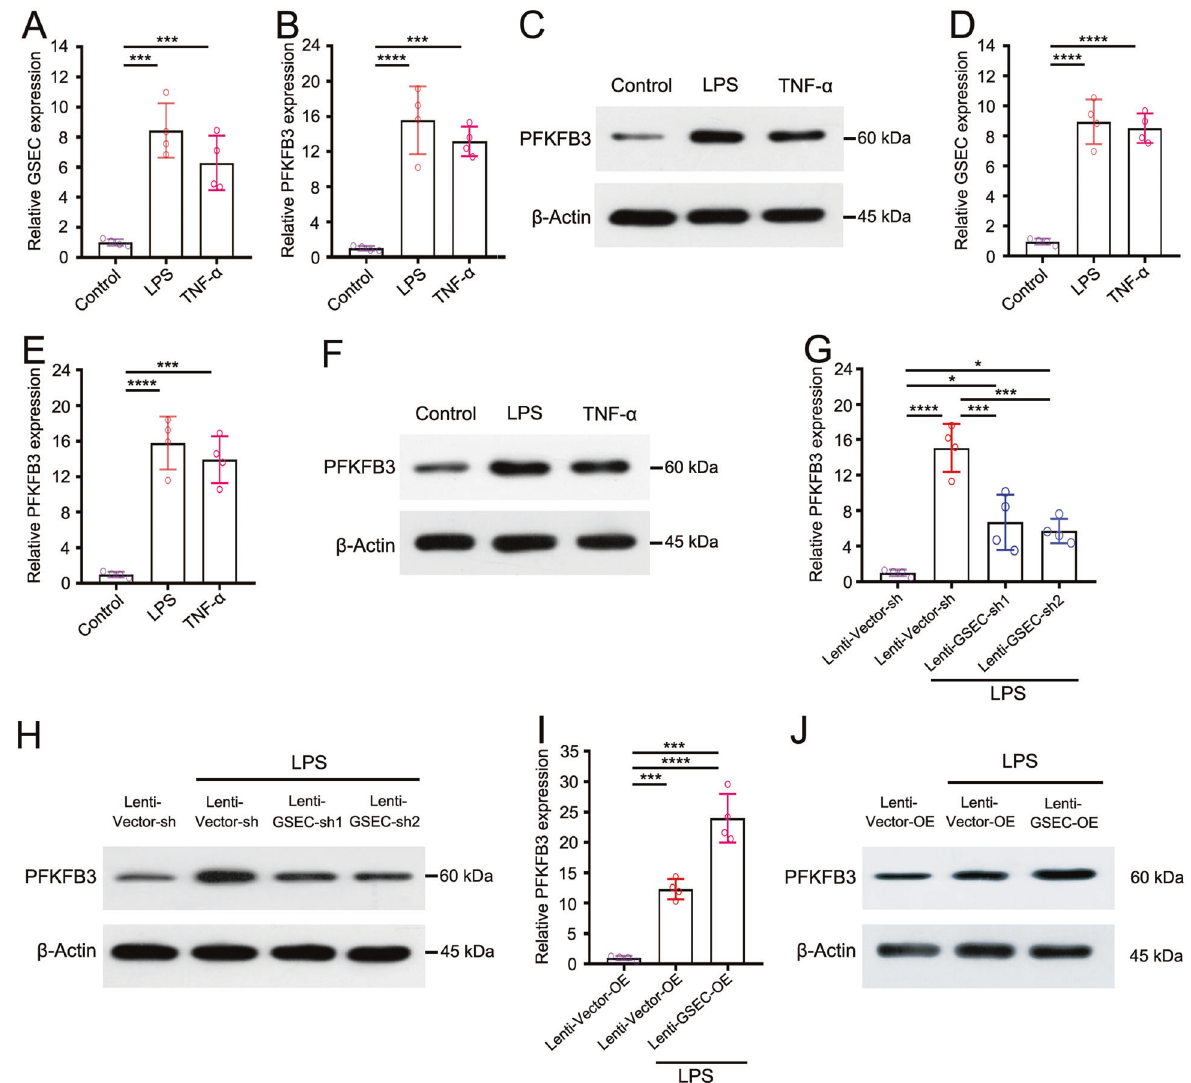
Fig. 4 GSEC is essential for PFKFB3 expression in in fl ammatory neutrophils. A The expression level of GSEC in primary human neutrophils. B The expression level of PFKFB3 in primary human neutrophils. C Western blot analysis of PFKFB3 in primary human neutrophils. D The expression level of the GSEC in dHL-60 cells. E The expression level of PFKFB3 in dHL-60 cells. F Western blot analysis of PFKFB3 in dHL-60 cells. G The level of PFKFB3 expression in GSEC-knockdown dHL-60 cells. H Western blot analysis for PFKFB3 in GSEC-knockdown dHL-60 cells. I The level of PFKFB3 expression in GSEC-overexpressing dHL-60 cells. J Western blot analysis of PFKFB3 in GSEC-overexpressing dHL-60 cells. Neutrophils and dHL-60 cells were treated LPS or TNF- α for 12 h. Statistics were calculated using one-way ANOVA with Tukey ’ s post hoc